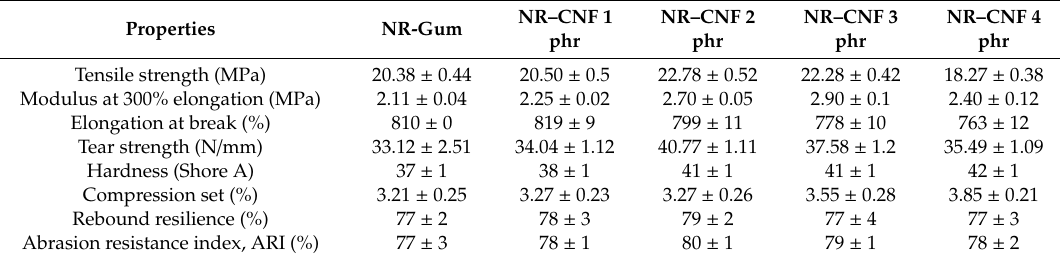
Table 4. Mechanical properties of NR–CNF